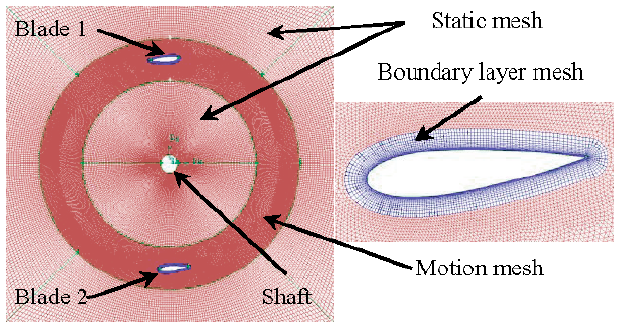
Figure 9. Meshing strategy for the VAWT rotor investigated in [44].